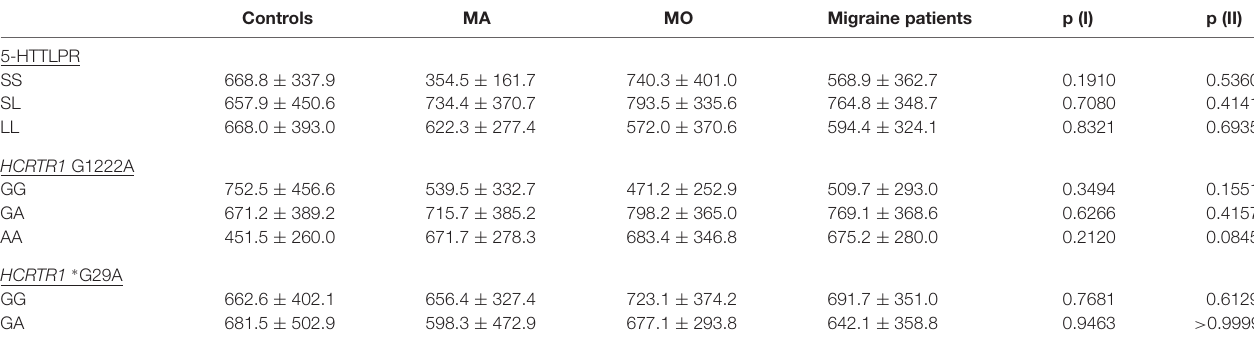
TABLE 6 | HCRT-1 concentration in MA, MO, both migraine patients (MA, MO) and control subjects regarding different genotypes of 5-HTTLPR, HCRTR1 G1222A and ∗ G29A. Controls MA MO Migraine